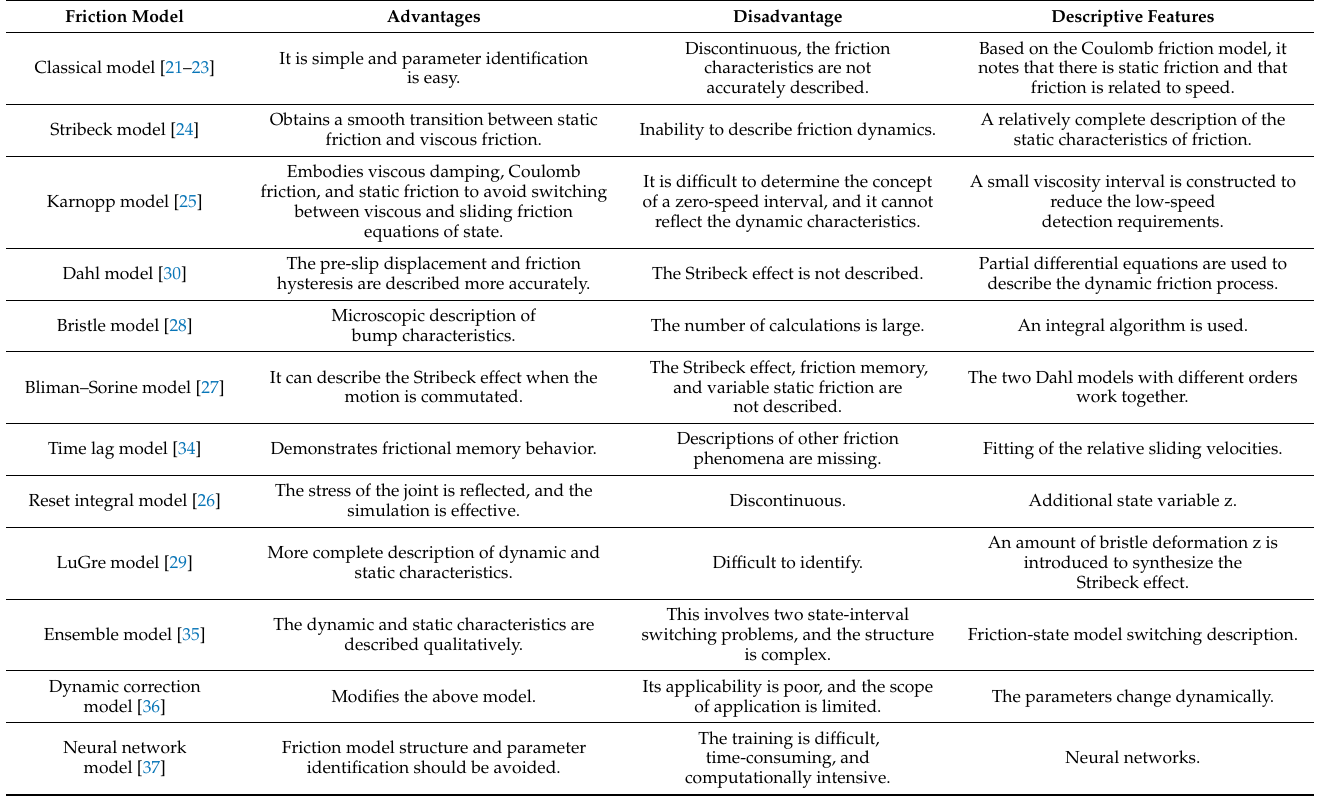
Table 1. Friction model and its description